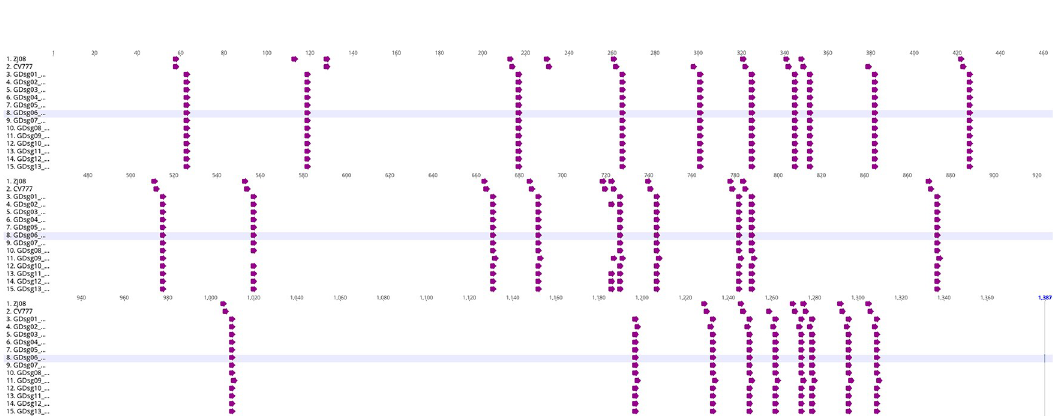
Fig 4. Predicted N-linked glycosylation sites of reference strains (CV777 and ZJ08) and 13 PEDV strains collected in this study. The sequences were aligned using MUSCLE with the Geneious software (Version 11.0.9). The purple arrow represents the predicted N-linked glycosylation site based on the consensus N-X-S/T (X can be any amino acid except proline) glycosylation motif.